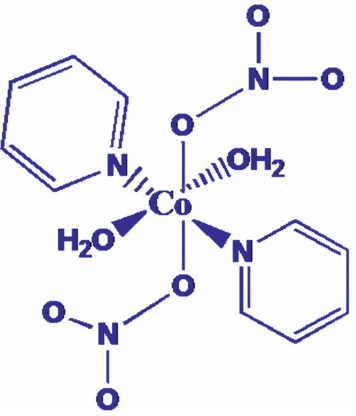
Figure 1: Structure of [Co(py) 2 (H 2 O) 2 (NO 3 ) 2